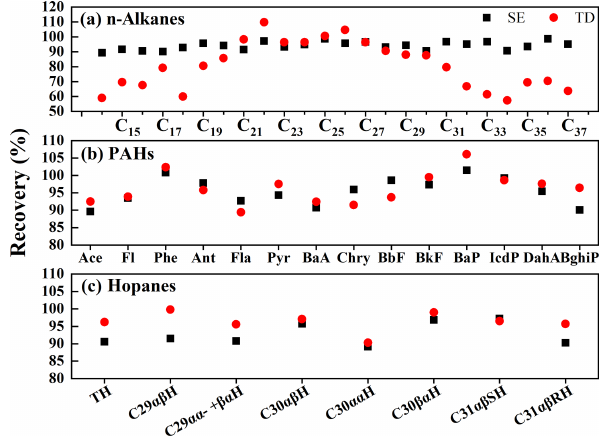
Figure 2. The recoveries of n-alkanes (a) (C n is the straight- chain n-alkanes with carbon numbers from 14–37), PAHs (b) and hopanes (c) by SE-GC-MS and TD-GC-MS. The full names of in- dividual abbreviations are shown in the